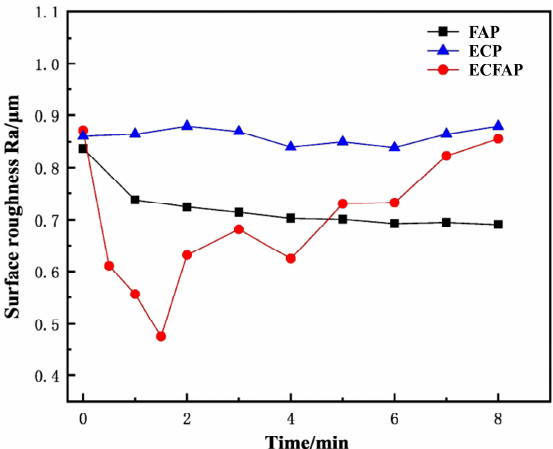
Figure 11. Time evolution of surface roughness of samples subjected to different polishing treat-